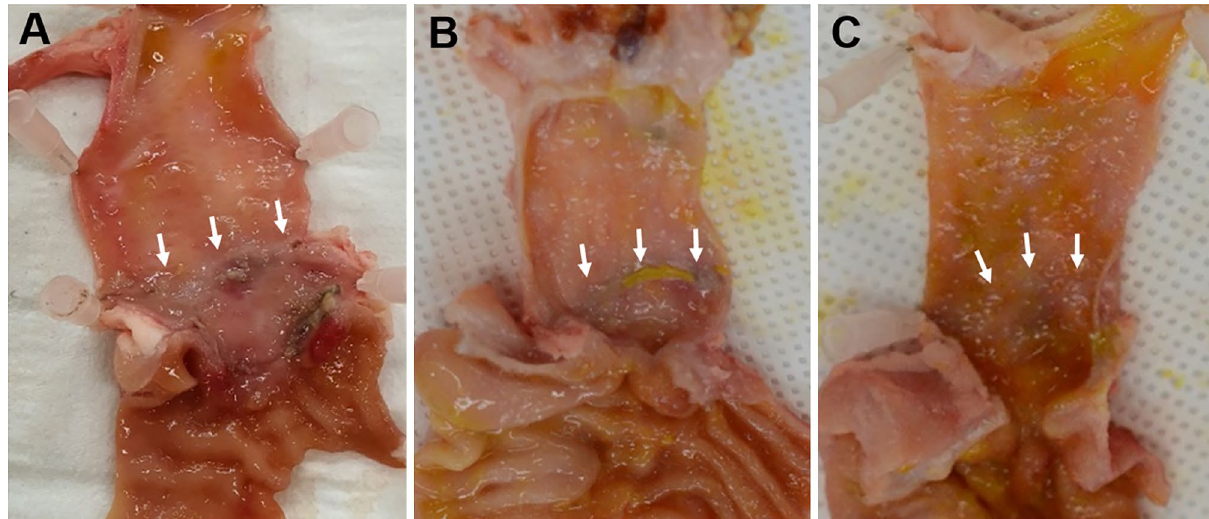
Figure 2. Gross pathology. Gross pathology at 4 weeks after stent insertion showing better healing in the stricture area (white arrow) in the steroid-eluting stent groups ( B , 15 mg triamcinolone; C , 30 mg triamcinolone) compared to the control group ( A ). The degree of healing was greatest in C , reflecting a dose- dependent relationship between the extent of healing and steroid